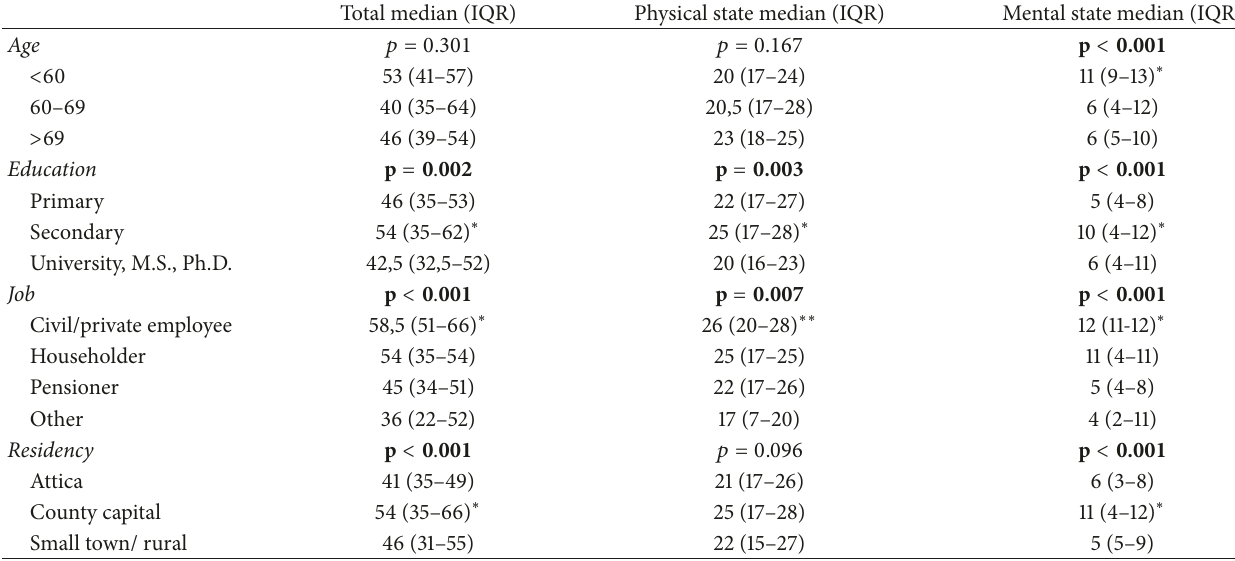
Table 4: Associations between patients’ characteristics and quality of